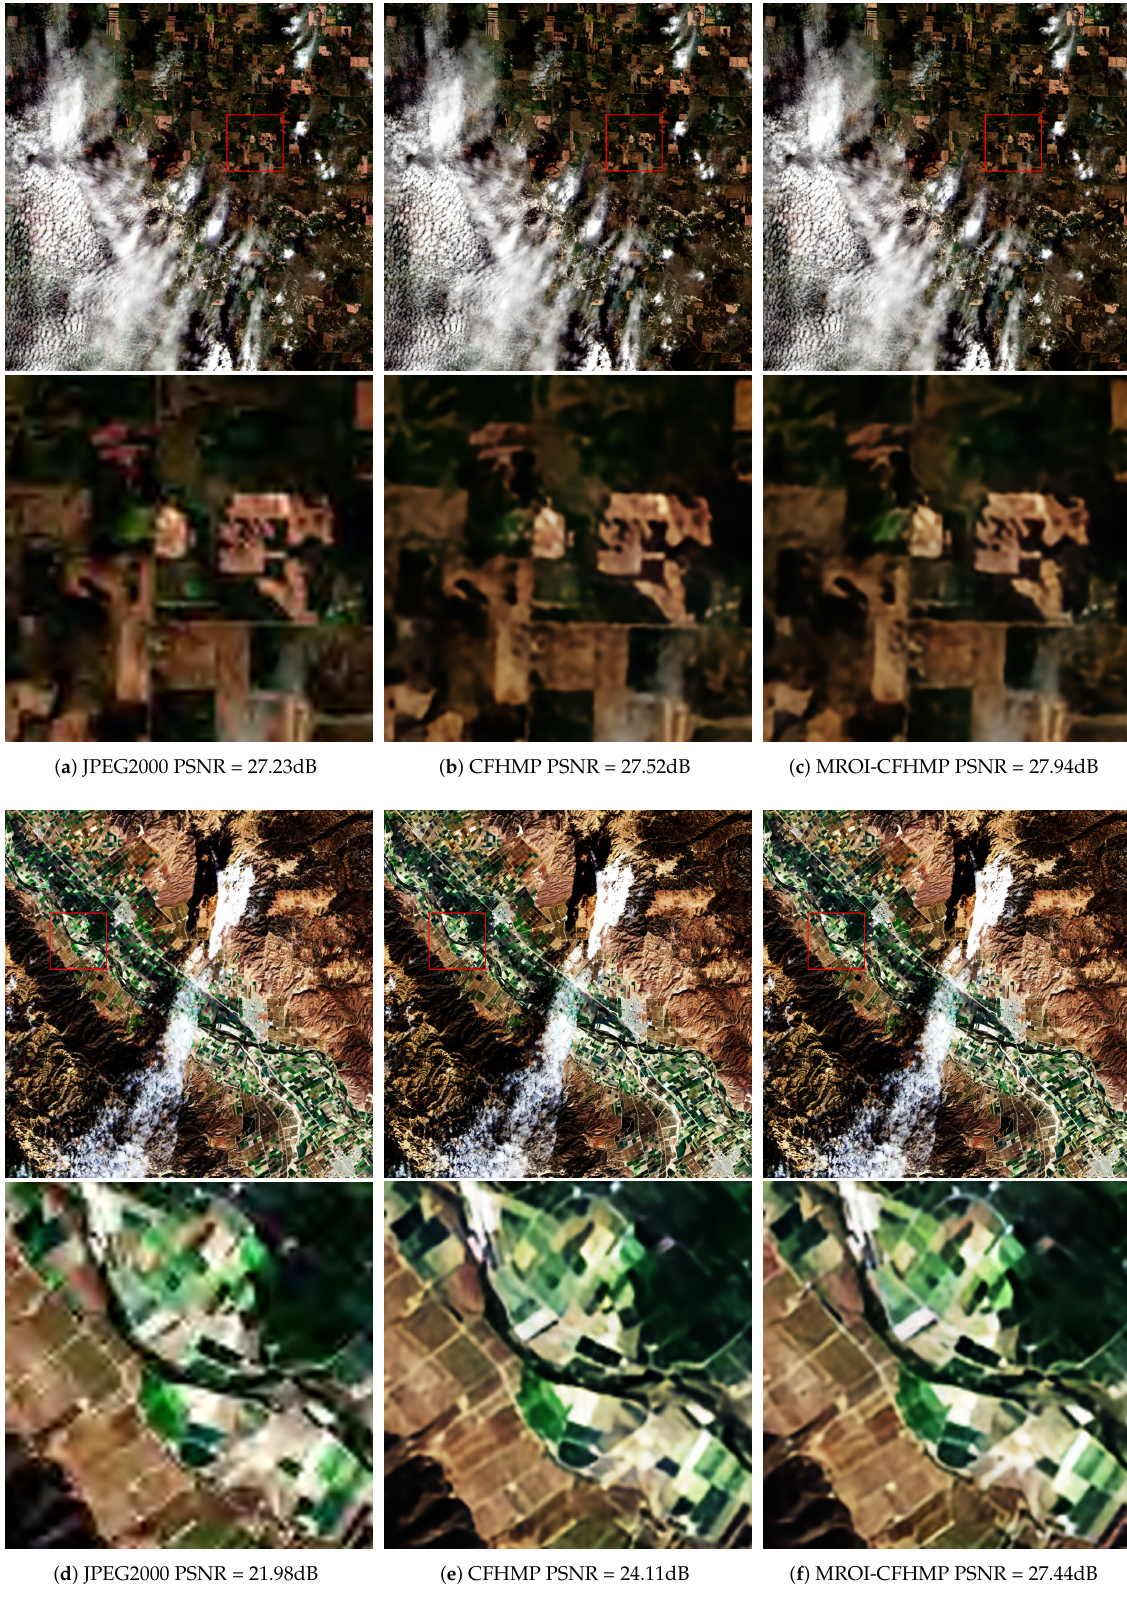
Figure 7. Comparison of Subjective Performance of Different Compression Algorithms on the Landsat Image Test Set with bpp =